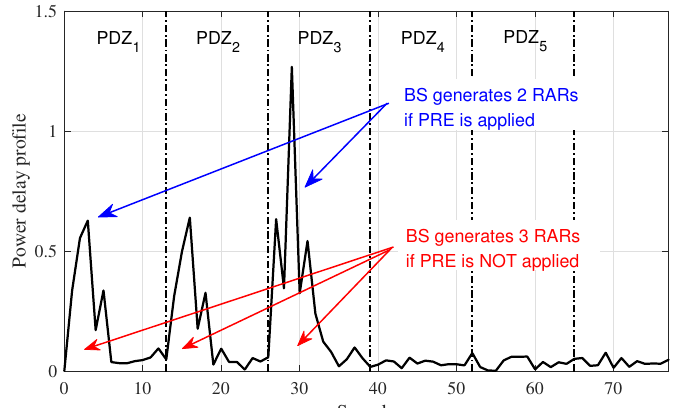
Figure 2. An example of preamble detection result and expected responses according to whether the transmission of multiple preambles is allowed or